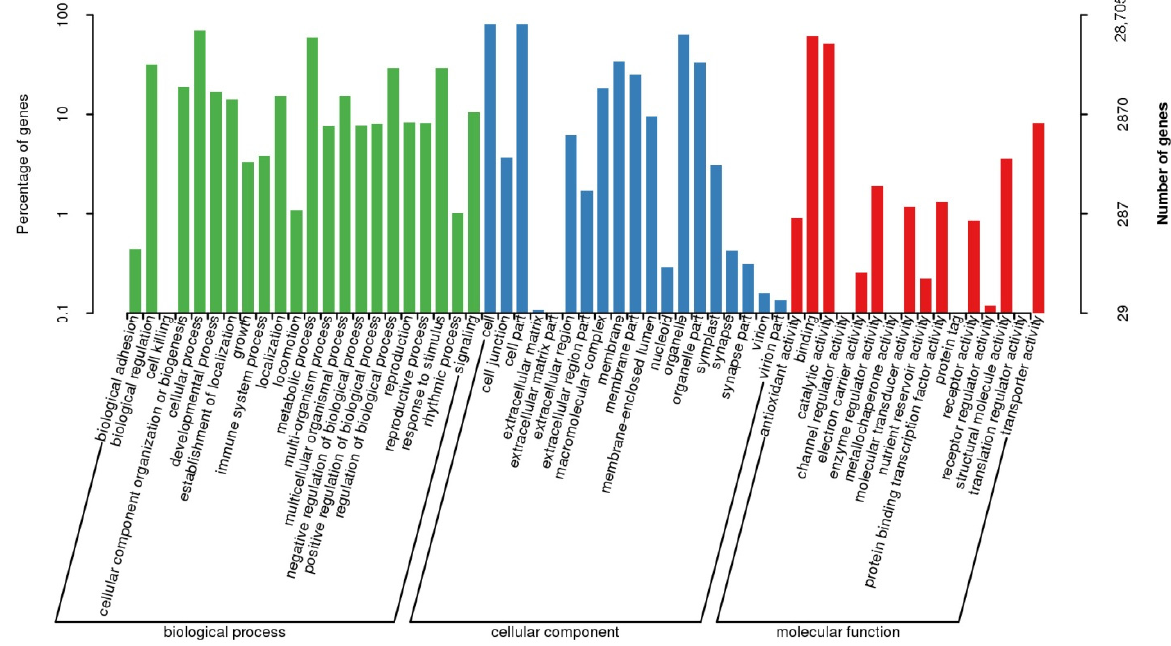
Figure 2. Functional annotation of loquat transcripts based on gene ontology categorization. A total of 28,705 unigenes were classified in the categories ‘biological process’ (24,099), ‘cellular component’ (25,113), and ‘molecular function’ (24,690). Note: The left x -axis represents the % of a specific class of genes in the main category. The right y -axis represents the number of genes in each category.